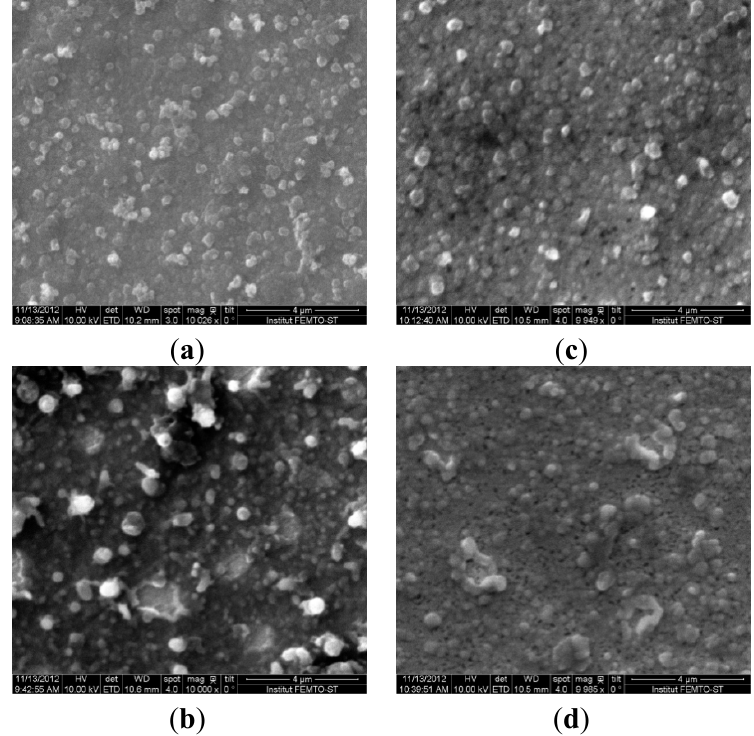
Figure 1. 2D SEM image of ( a ) PEDOT and ( b ) PEDOT-Ty coating deposited by potentiostatic procedure; 2D SEM image of ( c ) PEDOT and ( d ) PEDOT-Ty coating deposited by sinusoidal voltage of 50 mV amplitude.